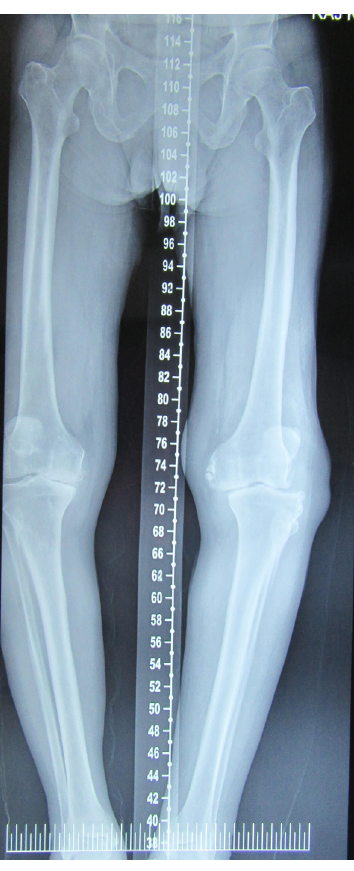
Figure 1. Scannogram of the bilateral lower limb showing varus alignment of both the knees with 10 (cid:2) tibiofemoral angle of the left knee.